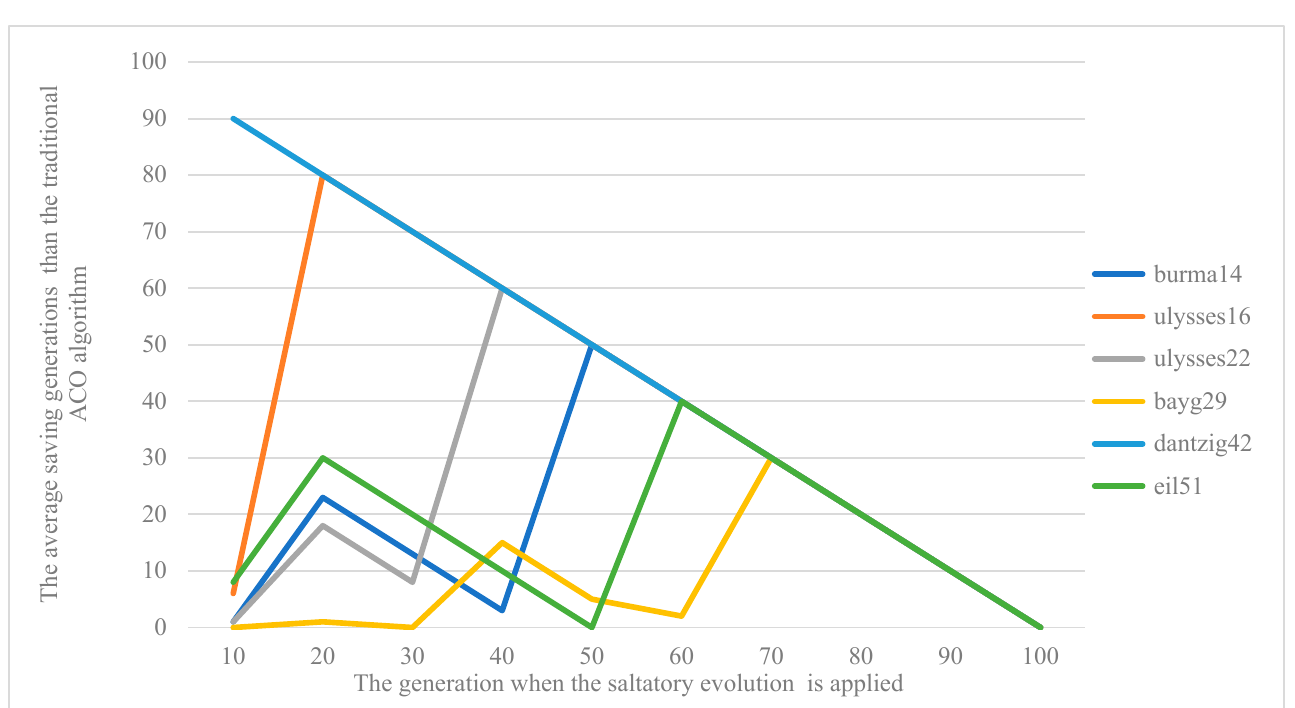
Figure 5. The optimization results of SEACO algorithm for data sets where n is in (0, 100].